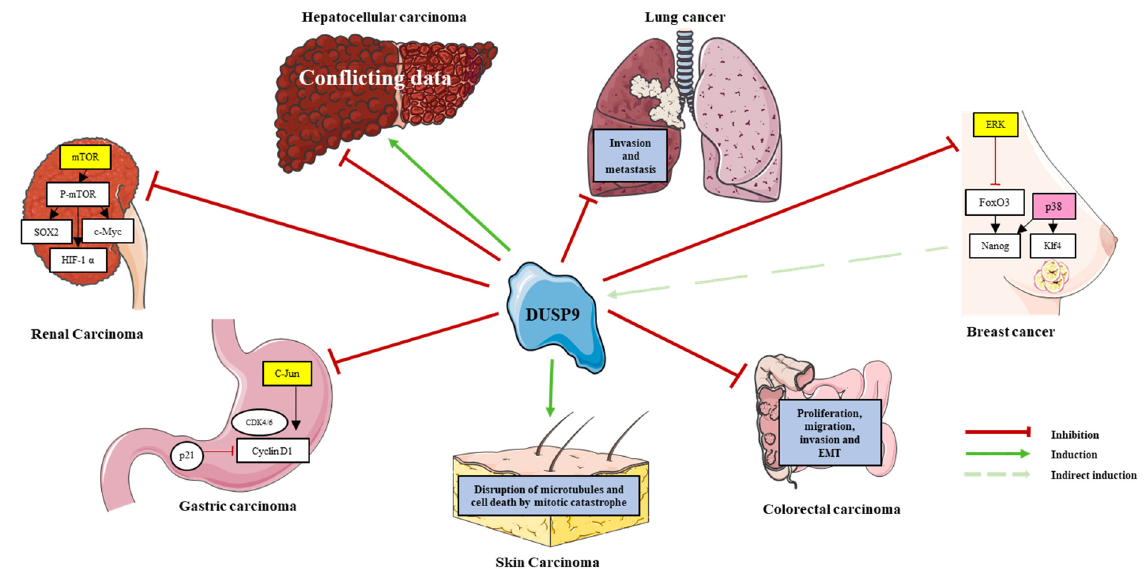
Figure 3. Role of DUSP9 in various cancers. Positive and negative effect of DUSP9 (see legend at the bottom right) on putative molecular pathways and oncogenic processes in the corresponding cancer. Targets of DUSP9 phosphatase (shown in yellow boxes) are inactivated, and this inactivation induces p38 kinase activity (shown in pink box) in breast cancer. See Section 6 for a fuller description.